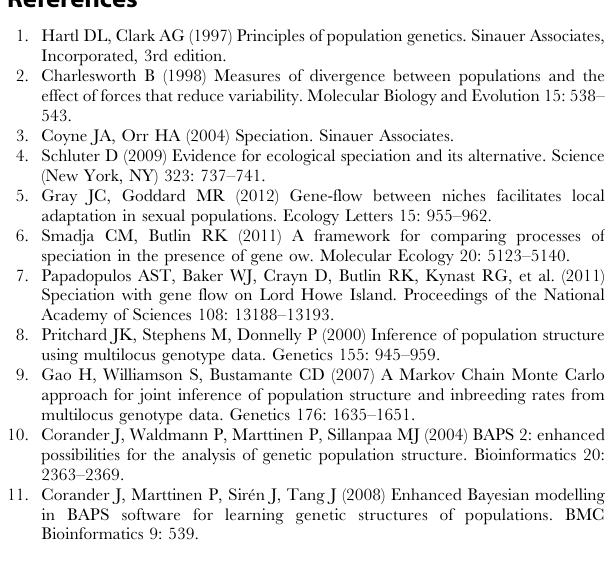
Table S1 Pairwise matrix of R 2 values between conti- nents for the human dataset. Table S2 Pairwise matrix of R 2 values between regions for the Saccharomyces cerevisiae